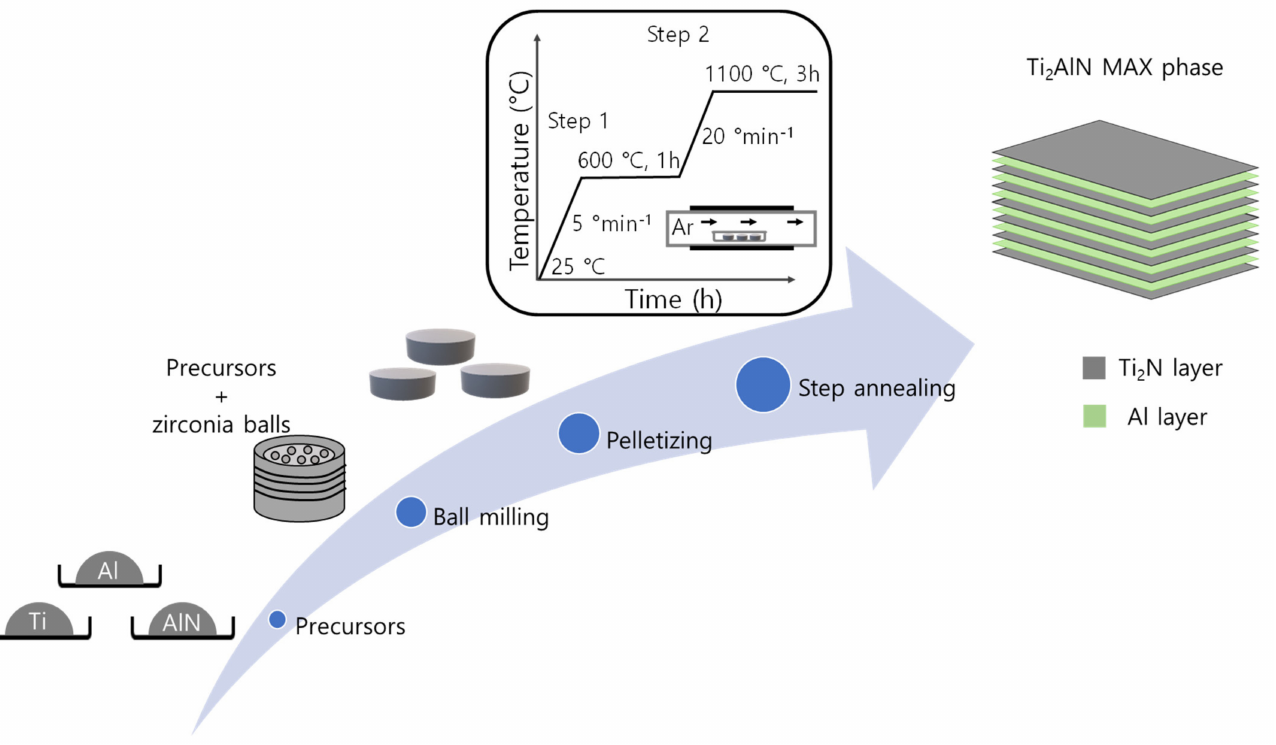
Figure 1. Schematic illustration of Ti 2 AlN MAX phase synthesis by step annealing